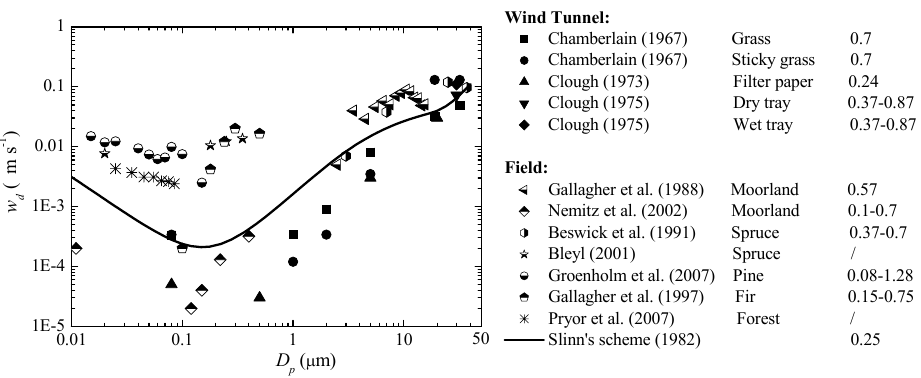
Figure 1. Some existing measurements of deposition velocities against particle size for different surfaces.